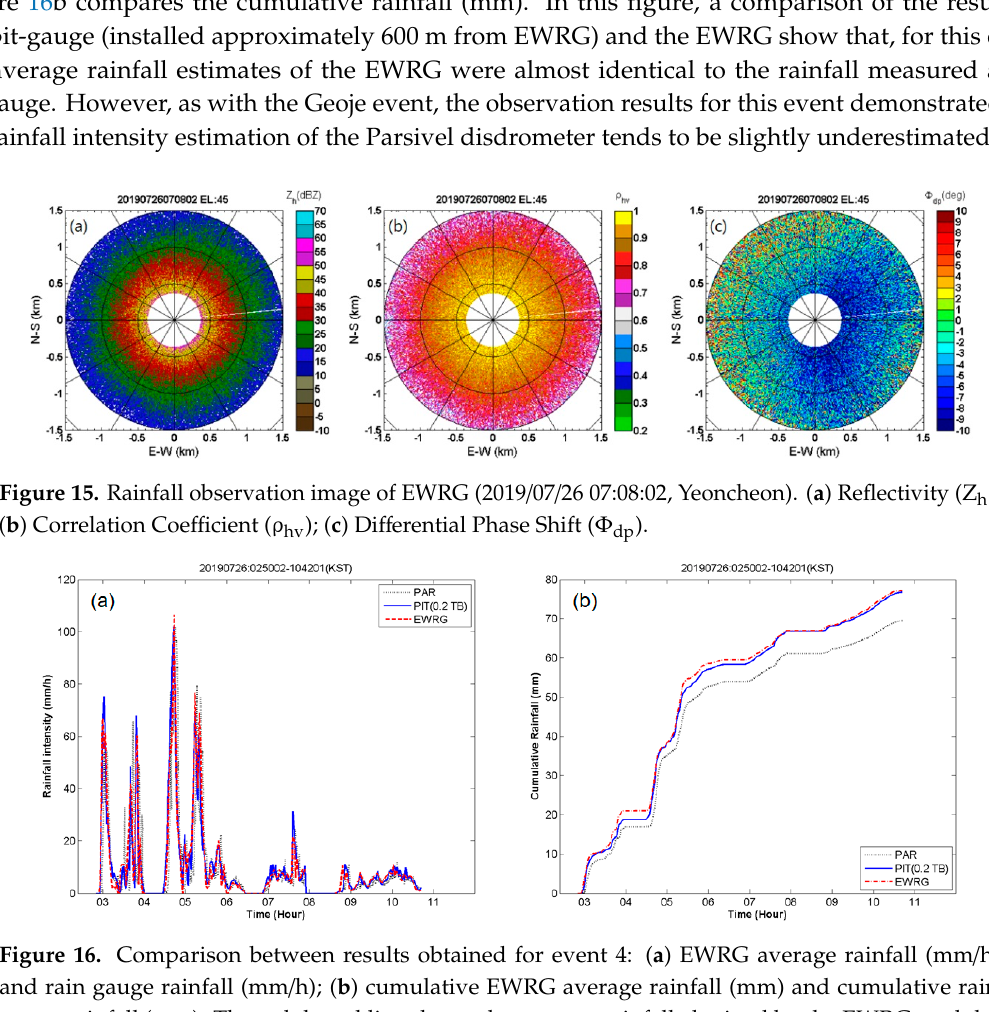
Figure 14. EWRG testbed at Yeoncheon SOC center. ( a ) Layout of the EWRG and complex pit-gauge; ( b ) EWRG installation; ( c ) Pit-Gauge and Parcivel installation. On 26 July 2019, heavy rain (event 4), caused by a strong seasonal rain front, hit the central and northern parts of the Korean Peninsula, causing a downpour exceeding 100 mm/h. EWRG